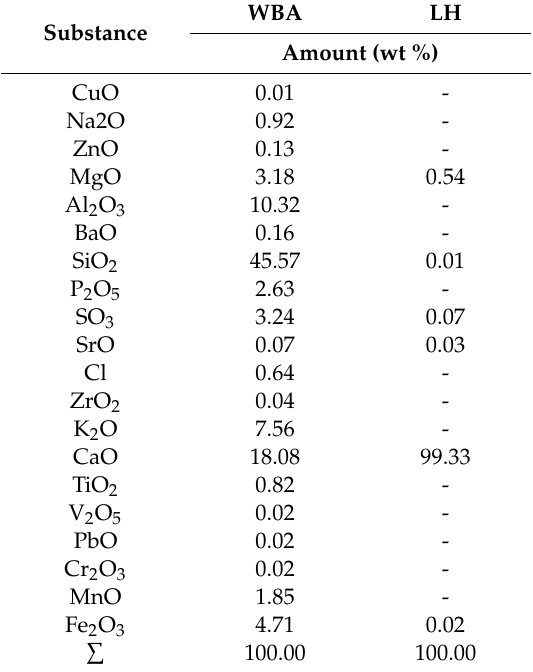
Table 5. X-ray fluorescence analysis (XRF) chemical composition of WBA and LH.